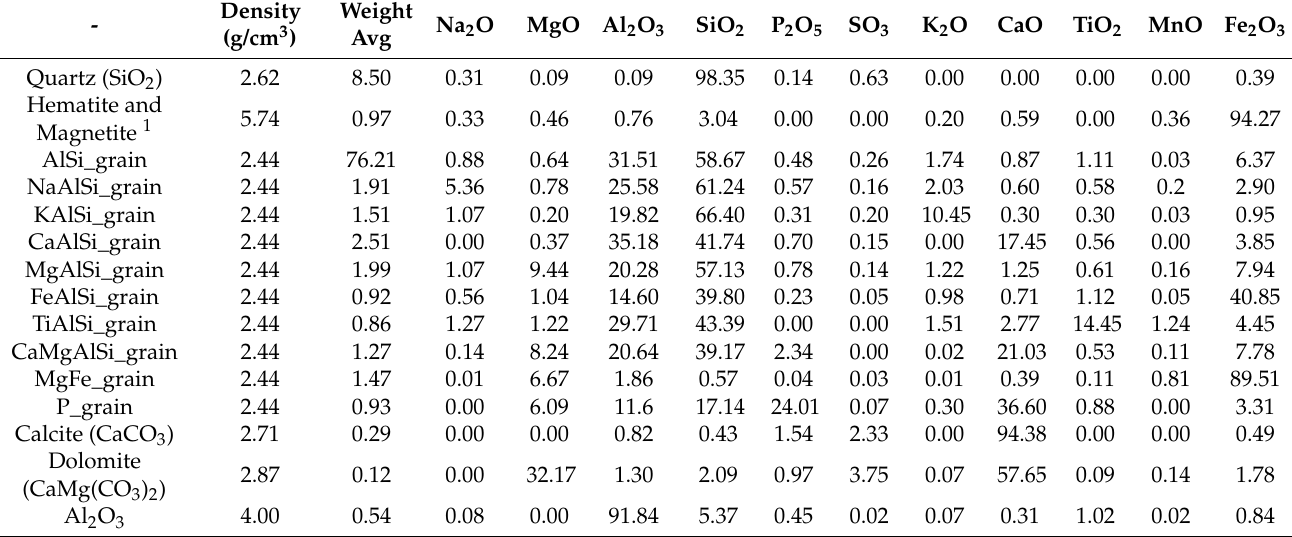
Table 4. Chemical composition of phase domains of FA particles obtained with PARC (wt%).